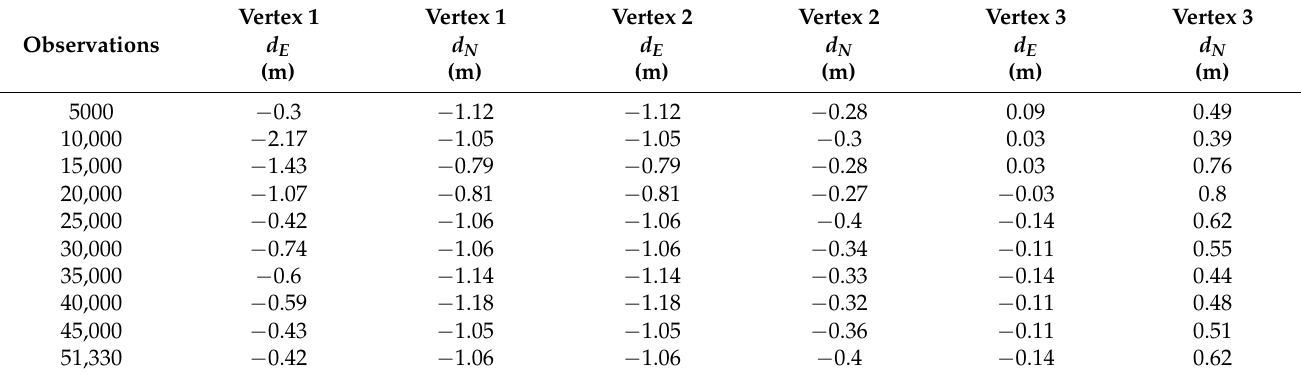
Table 9. The d E , d N error from the East, North coordinates obtained from the means of different number of observation.